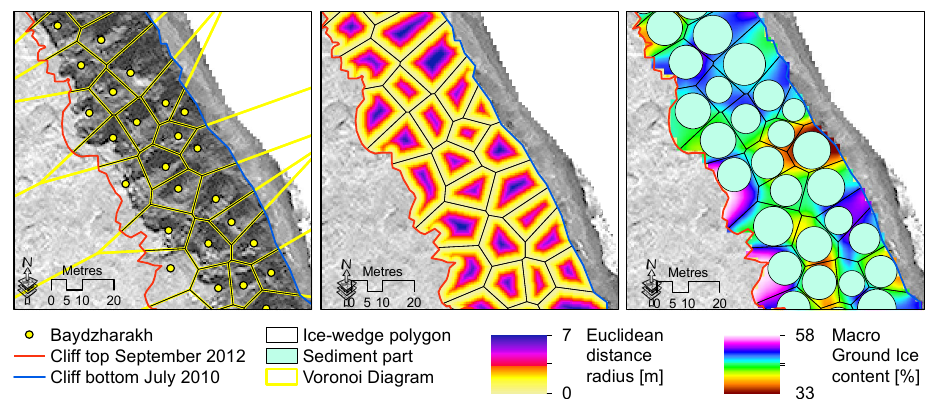
· · Figure 8. Left: points mark mapped baydzharakh centre locations, used for derivation of the Voronoi diagram. Middle: determination of the Euclidean distance within each polygon. Right: construction of largest possible circles within polygons using maximum Euclidean distance as radius, representing the sediment component of the subsurface. Calculation and interpolation of macro ground ice content between circles based on the ratio of area occupied by circles and total polygon area (8 August 2010 WorldView-1 imagery as